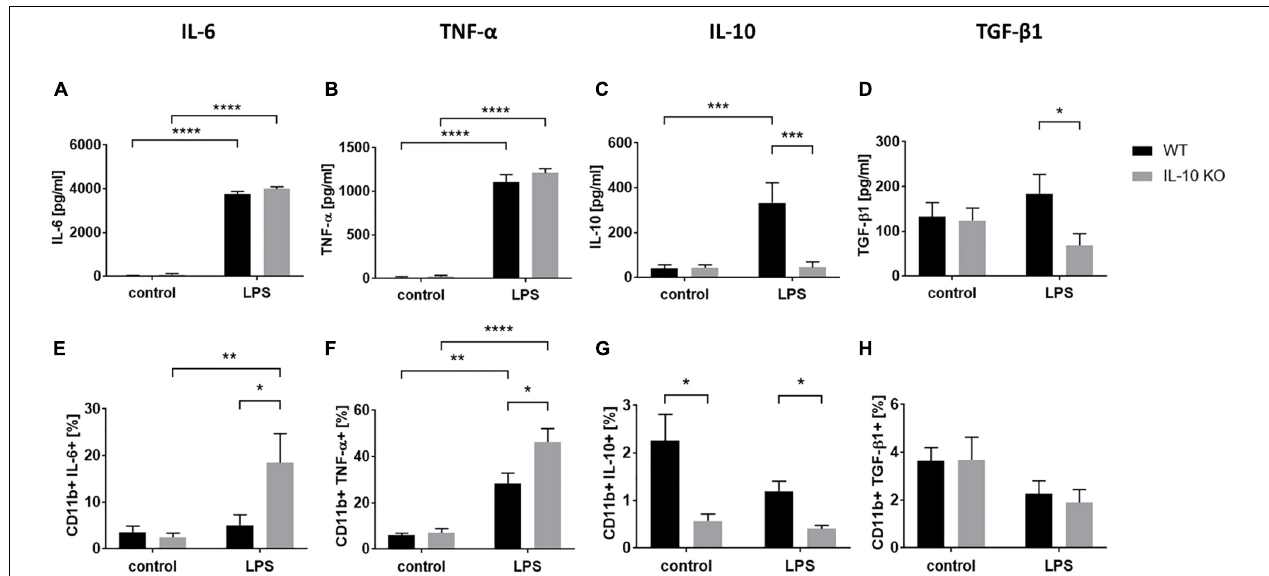
FIGURE 2 | Cytokine pattern of WT (black bars) or IL-10 KO (gray bars) microglia of control group or after LPS treatment. ELISA data in pg/ml, (A) IL-6 ( N = 11), (B) TNF- α ( N = 11), (C) IL-10 ( N = 10), and (D) TGF- β 1 ( N = 8), Mean ± SEM. Flow cytometric data in % CD11b+ cells, (E) IL-6, (F) TNF- α , (G) IL-10, (H) TGF- β 1 ( N = 5), mean ± SEM. One-way ANOVA, ∗ p < 0.05; ∗∗ p < 0.01; ∗∗∗ p < 0.001; ∗∗∗∗ p < 0.0001.